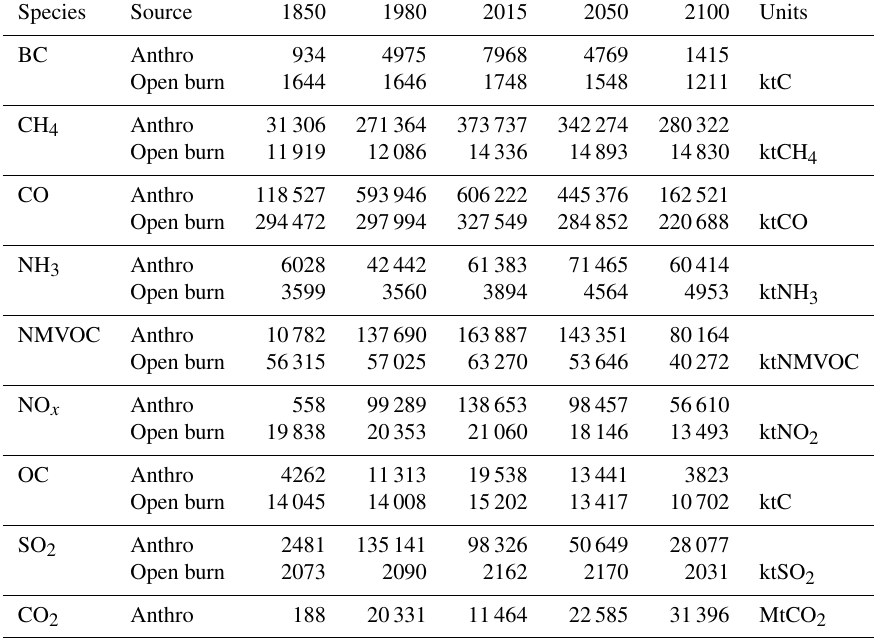
Table 3. Total anthropogenic and open burning global emissions for selected time periods. Values for 2050 and 2100 are from the SSP2-45 scenario. Only anthropogenic CO 2 emissions are shown since net open burning CO 2 emissions depend on land-use change history and are not provided in this